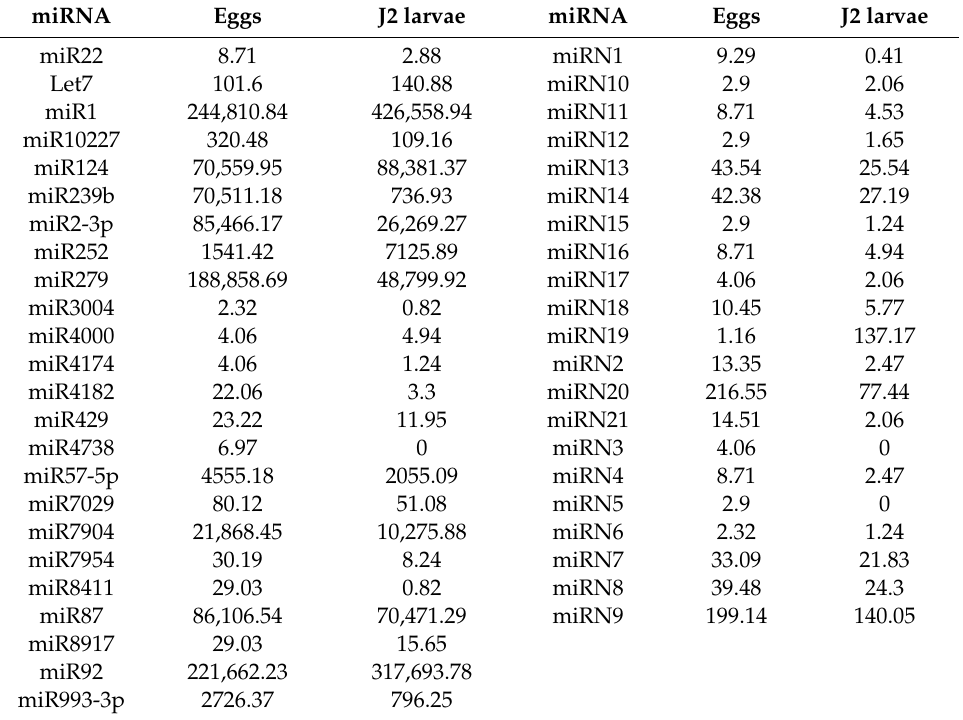
Table 3. The expression levels of 45 identified miRNAs in M. incognita eggs and J2 juveniles following cotton infection